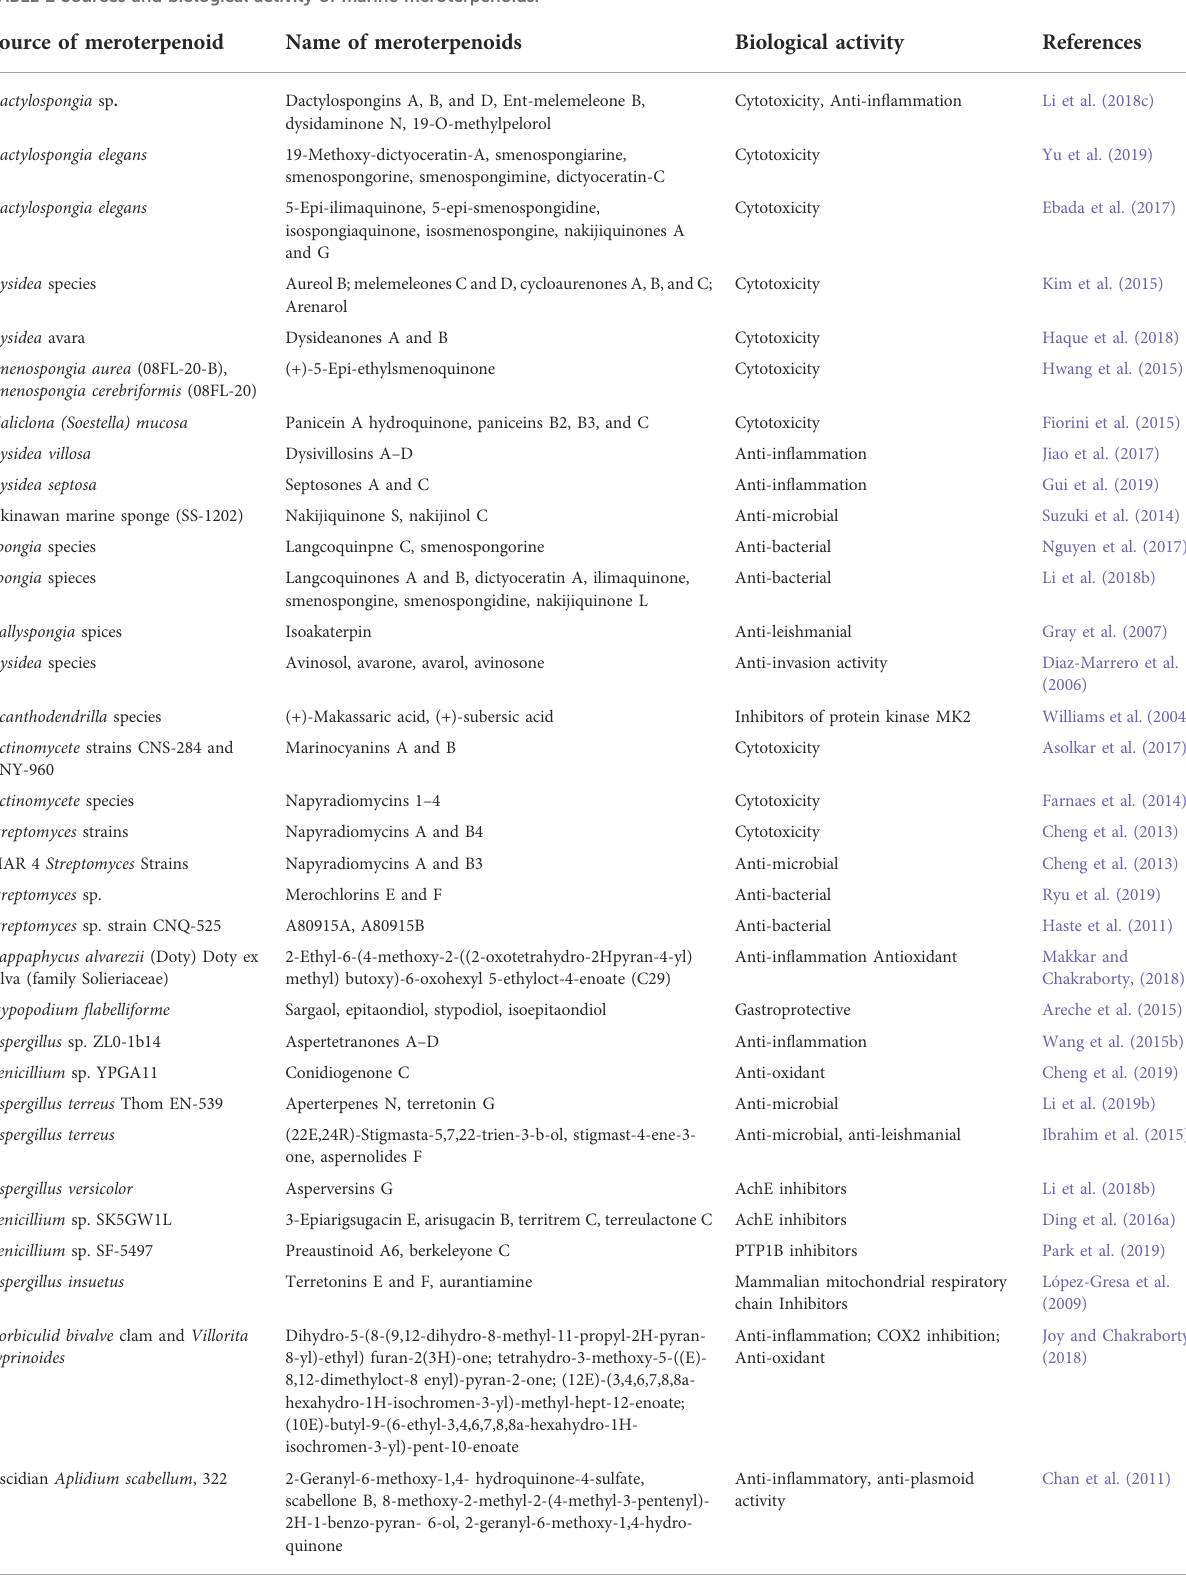
TABLE 2 Sources and biological activity of marine